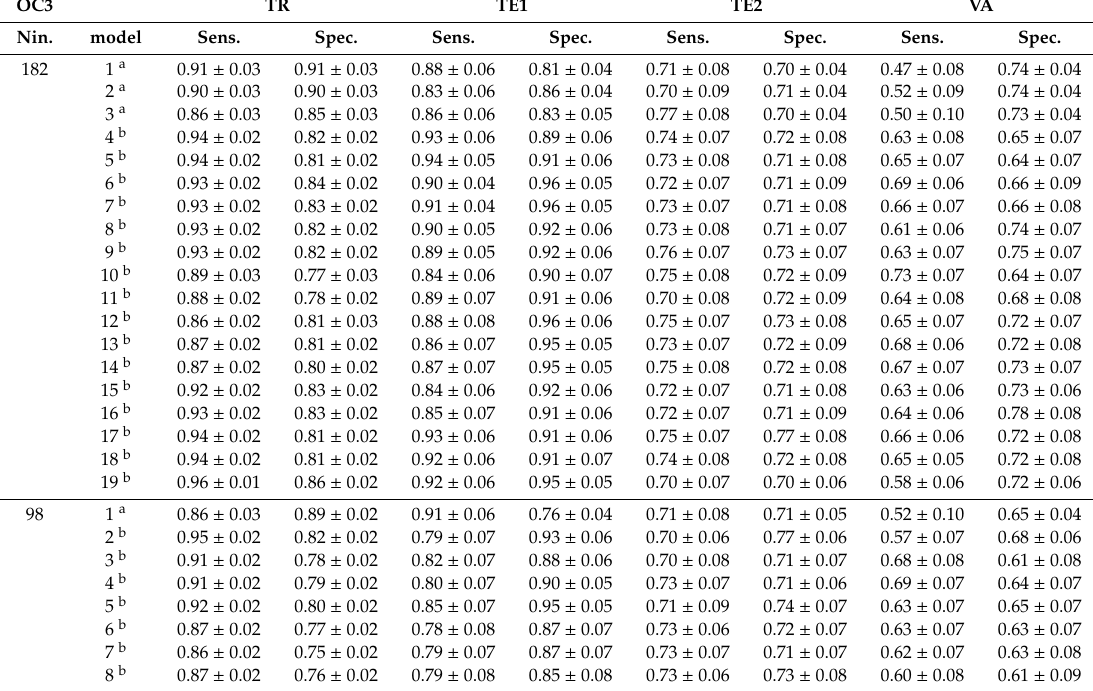
Table 4. The average values of sensitivity and specificity obtained for models optimized using optimization criterion 3. Average values and standard deviations are given for 100 models built using selected descriptors and di ff erent permutations of objects in training